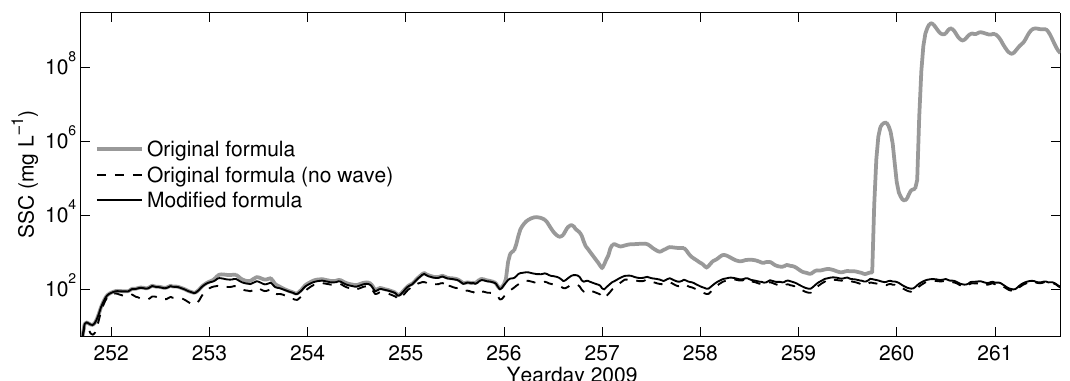
Figure 9. Comparison of time series of the modeled near-surface SSC measured at the point indicated by the cross in Figure 4b) using the original resuspension formula with (gray solid) and without (black dashed) waves and the modified resuspension formula with waves (black